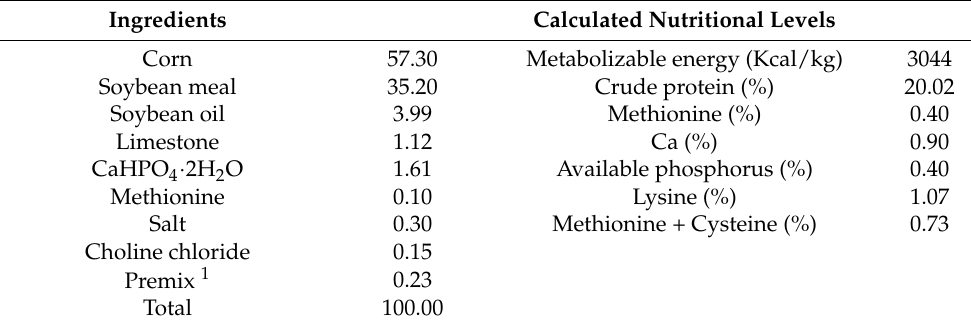
Table 1. Composition and nutrient levels of the basal